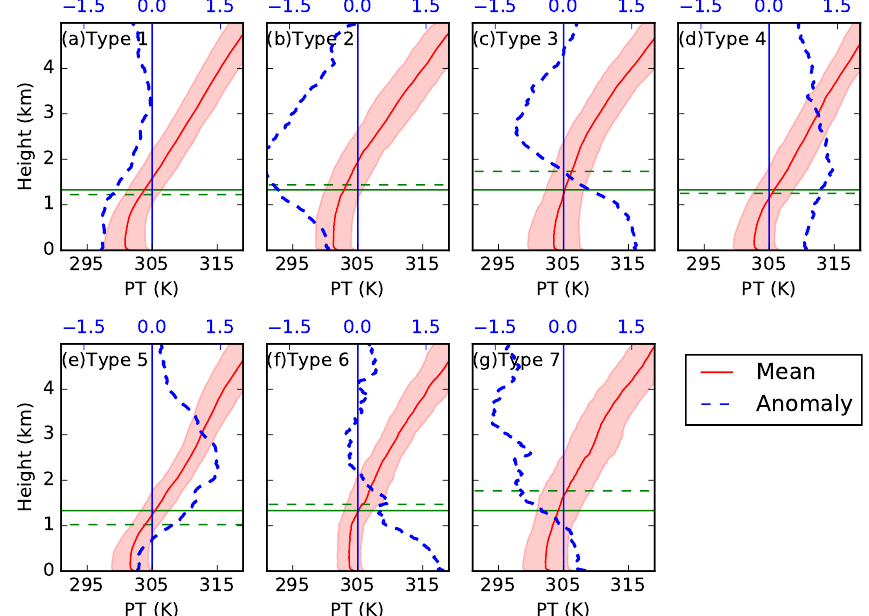
Figure 9. Vertical profiles of potential temperature (PT) at 14:00BJT associated with the seven types of synoptic pattern derived from soundings (red lines). Solid lines indicate average values and shaded areas show the uncertainty range (the mean ± 1 standard deviation). Green solid lines represent the summer averaged BLH and green dashed lines represent the average BLH for each synoptic type. The PT anomaly (subtracted from the summer averaged PT profile) for each synoptic type was also given by the blue dashed lines in each